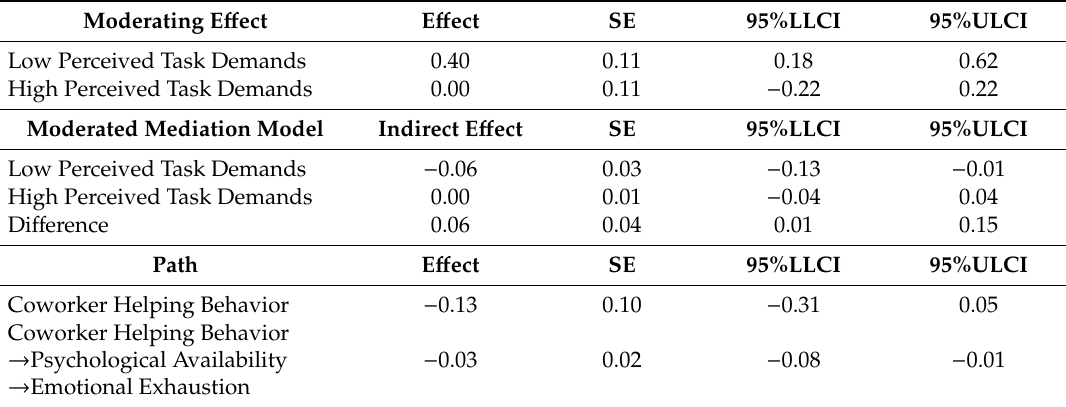
Figure 3. The moderating role of perceived task demands. Table 4. Results of the Monte Carlo bootstrapping